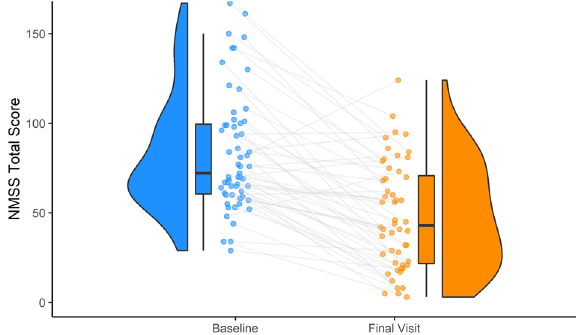
Fig. 4 NMSS total score evolution from baseline to fi nal visit. Violin plots representing the frequency and box plots representing the interquartile range containing 50% of the data, the median and the 95% con fi dence